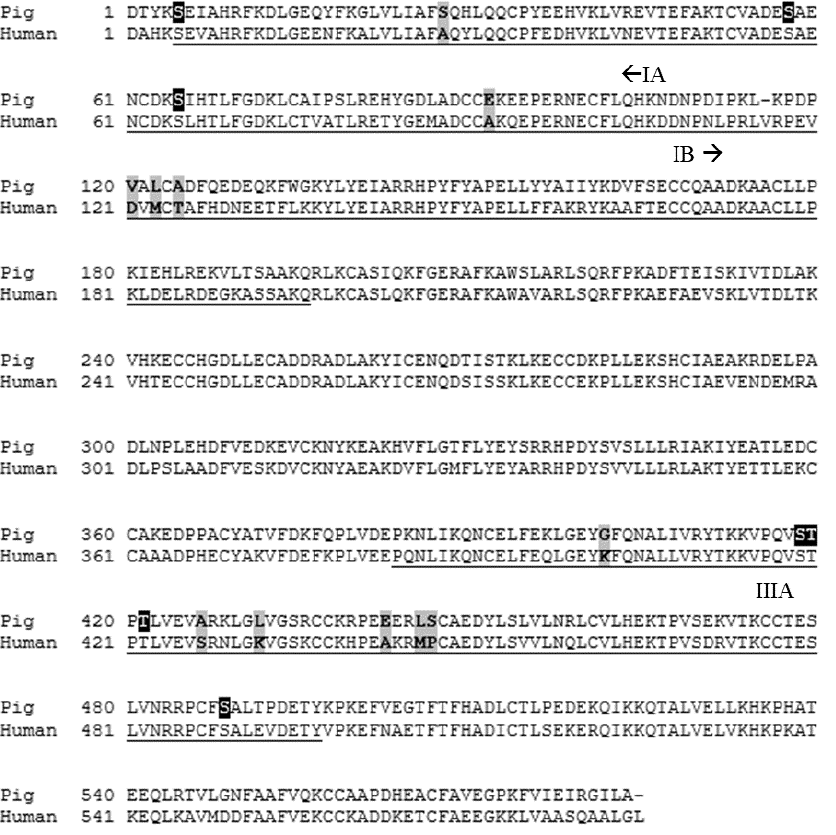
Figure 5. The amino acid sequence of human and porcine albumin [24,25]. Amino acids comprising the IA, IB, and IIIA binding domains of human serum albumin and the corresponding amino acids in pigs are underlined. Key amino acid differences are highlighted in grey, and phosphorylation sites are highlighted in black. Signal sequences have been excluded from the figure.